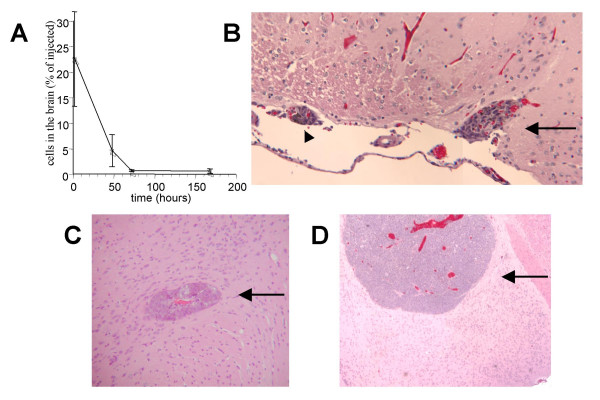
Metastatic brain tumor model. A) One hundred thousand 125I-deoxyuridine-labeled B16F10 cells were injected in the left internal carotid artery. Mice were sacrificed after 1, 24, and 48 hours, 3 days and 7 days. The left hemisphere was removed and the amount of radioactivity was measured by means of the ICN gamma-counter to determine the number of cells remaining in the brain. Note the rapid decline of radioactivity in the brain that remained stable after 72 hours. Hematoxylin-eosin staining of melanoma tumors developing in the brain after intracarotid injection (B-D). B) B16F10 cells lodged in a blood vessel (arrowhead) and cells invading the brain (arrow). C) B16F10 cells (arrow) growing in the brain parenchyma. D) Large tumor growing in the brain parenchyma (arrow).